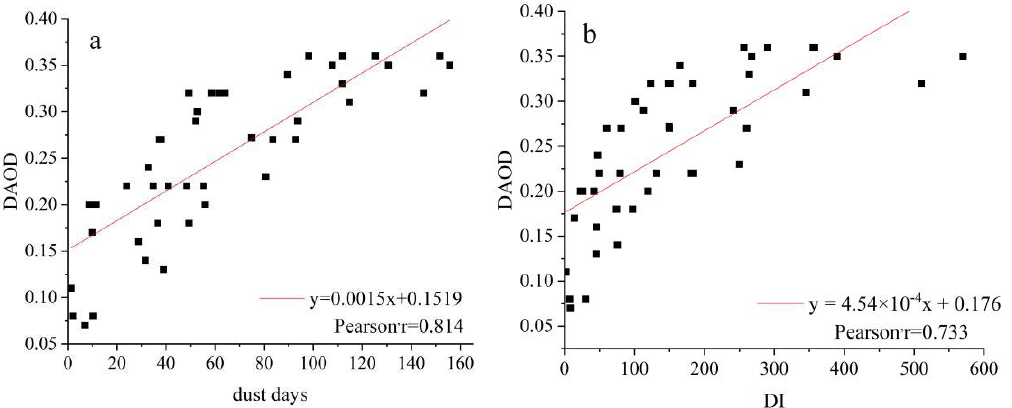
Figure 7. (a) Correlation analysis of annual average DAOD and dust weather days at 44 stations from 1989 to 2021; (b) Correlation analysis of multi-year average DAOD and DI.